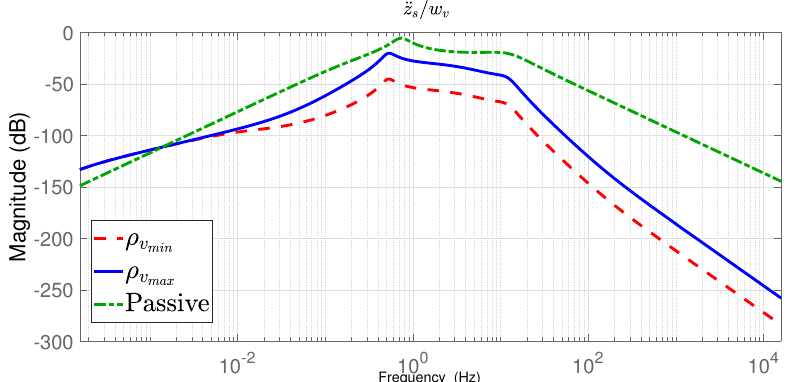
Figure 13. Bode diagram (from w v to ¨ z s ) of the closed-loop systems corresponding to the vertices of ρ v and ρ v , and of the passive system. max min